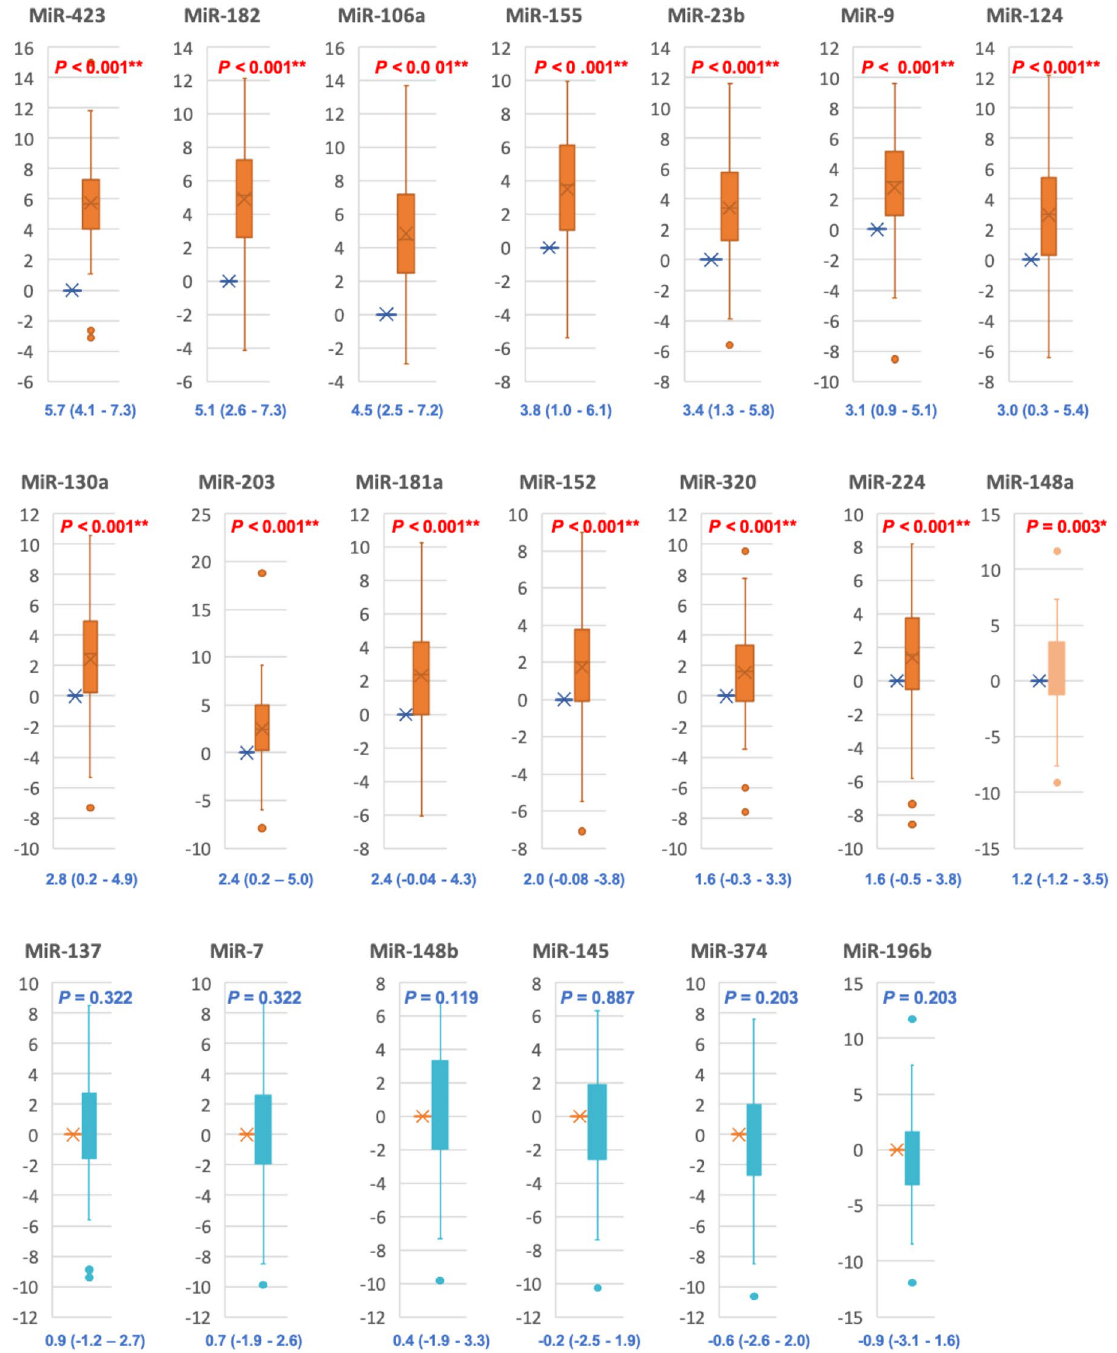
miR-152, miR-155, miR-181a, miR-182, miR-196b, miR-203a, miR-224, miR-320a, miR-374b, and miR-423. SNORD68 and RNU6B were used as endogenous controls. The values are represented as median (Q1 and Q3) using Whiskers and bars. Control level were set at the Log2 fold change equals 0 and all values were log- transformed. Mann–Whitney U test was used for comparison. * Significant at p value < 0.05, ** Significant at p value <